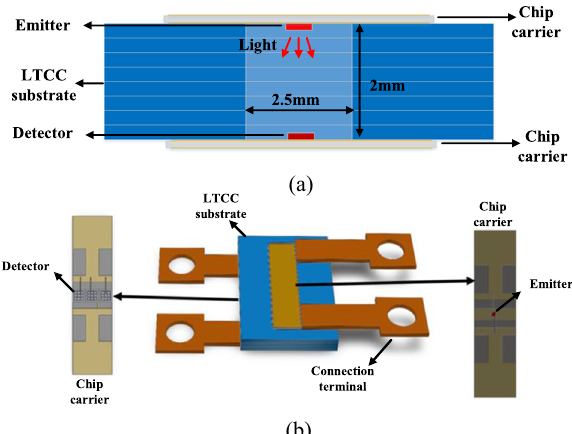
Figure 1. ( a ) Cross-sectional view and ( b ) 3D model view of the LTCC-based high-temperature optocoupler.